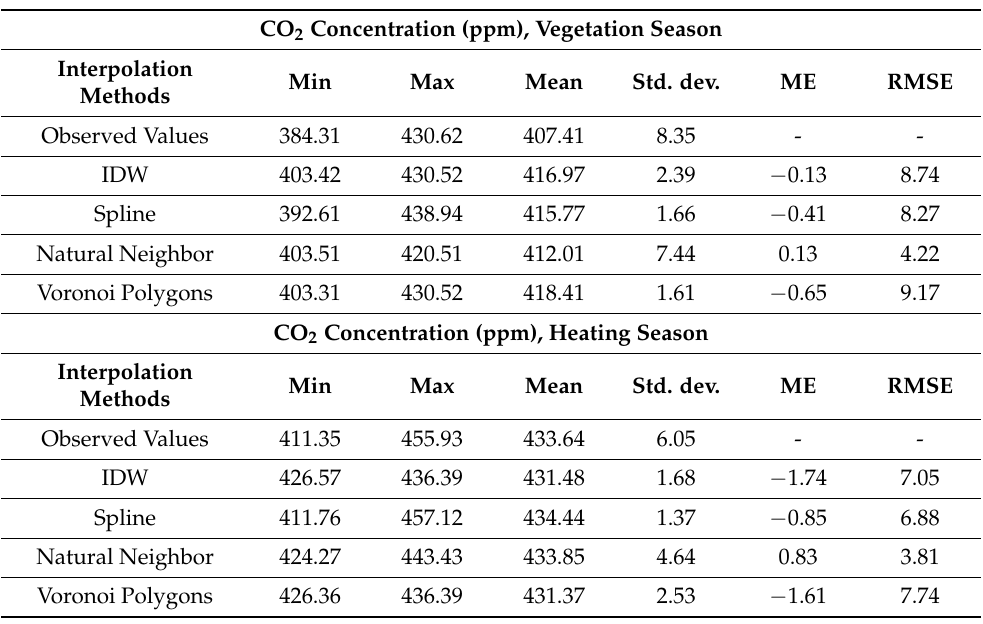
Table 2. Summary statistics of the selected interpolation methods: vegetation vs. heating season.